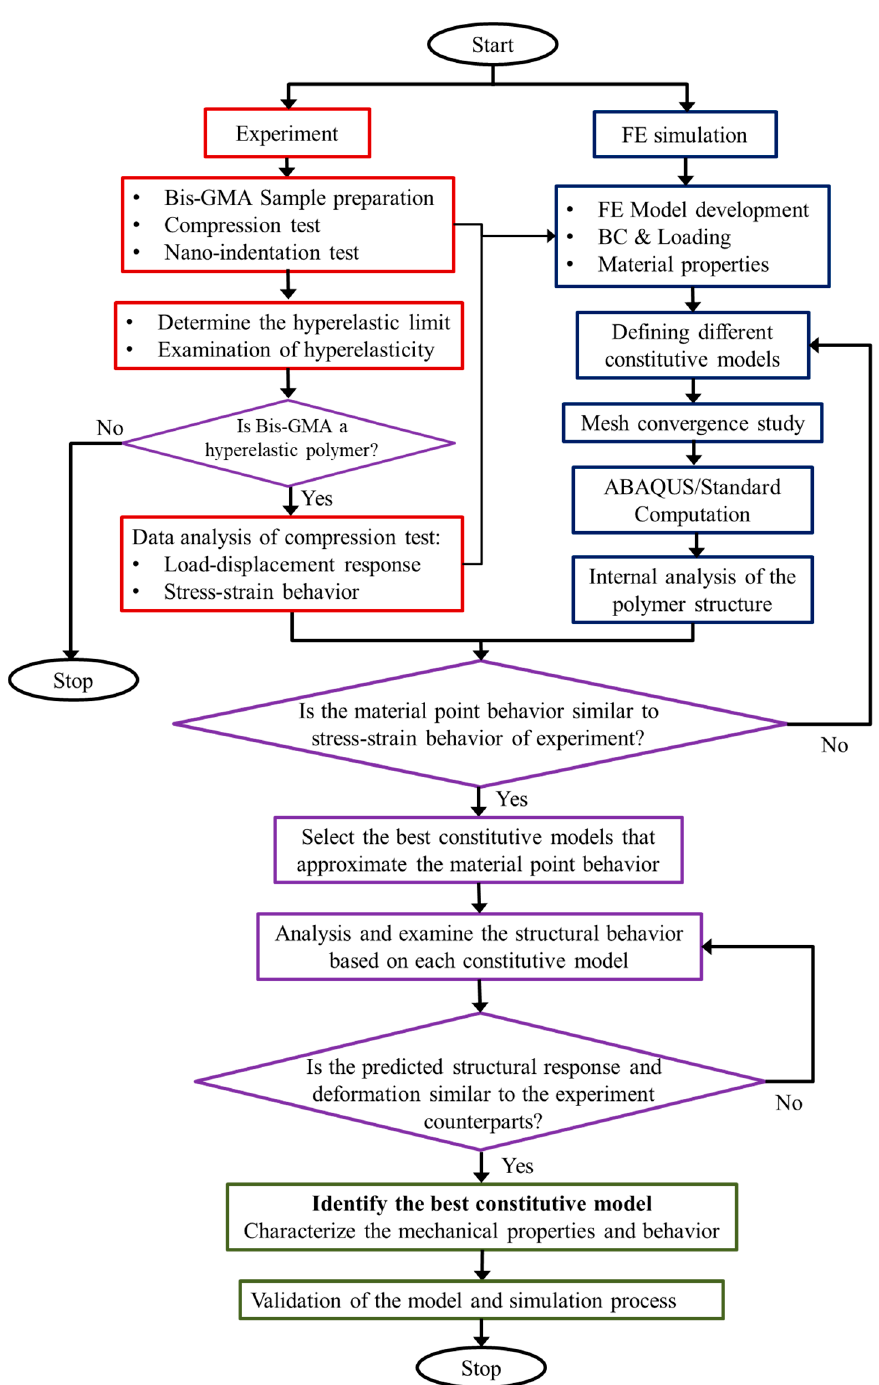
Figure 2. Flowchart of the hybrid experimental-computational approach to determining the mechanical behavior of hyperelastic polymers.